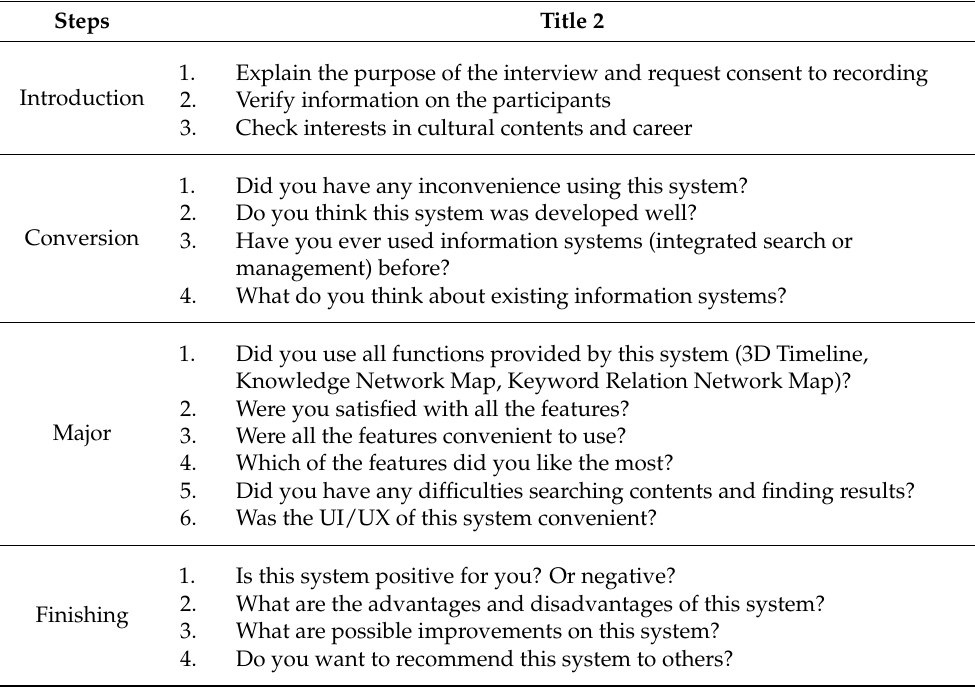
Table 3. Questionnaire for In-Depth